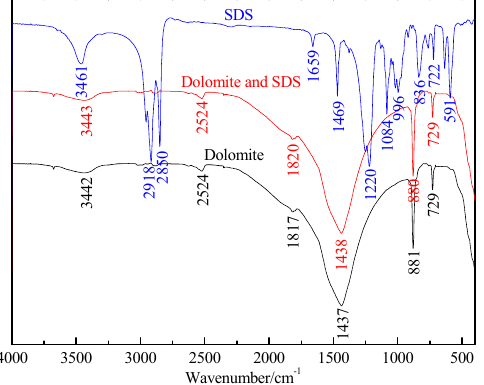
Figure 9. Effect of pH on recovery (SDS dosage is 3 × 10 -4 mol/L). Minerals 2017 , 7 , 29